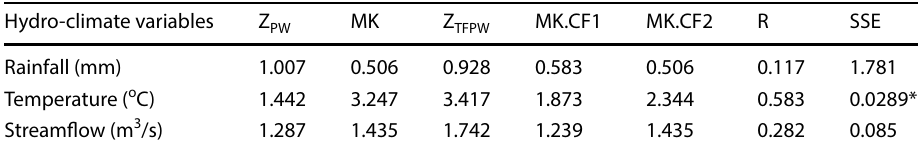
Table 4 Results of summarized annual statistical test trends of hydro-climate